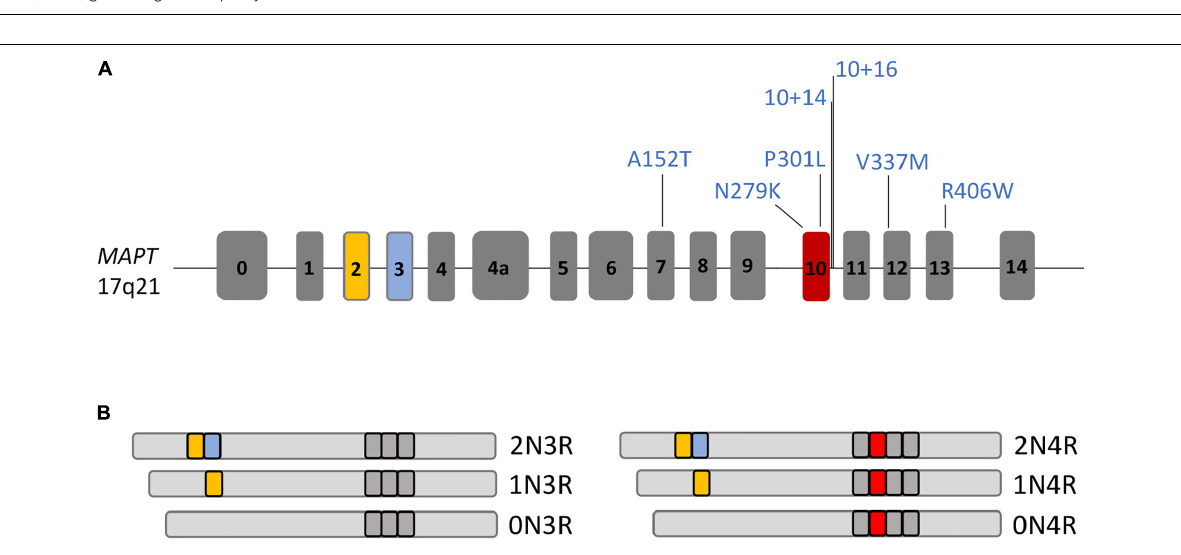
FIGURE 2 | Classification of frontotemporal dementia / frontotemporal lobar degeneration. (A) FTLD is subdivided into FTLD-tau with deposition of hyperphosphorylated tau, FTLD-TDP with TDP-43 pathology, FTLD-FET with deposition of FET proteins as well as FTLD-UPS with deposition of ubiquitinated proteins. The percentage, clinical presentation, deposited proteins and associated mutations are listed for each FTLD subtype. (B) FTLD-tau (highlighted in blue) is further subdivided into 3R and 4R tauopathies as well as a small group of patients with unaltered 3R:4R ratio. Human iPSC models have been established for some FTLD-tau subtypes (in red). bvFTD, behavioral variant of frontotemporal dementia; PSP, progressive supranuclear palsy; CBS, corticobasal syndrome; svPPA, semantic variant of primary progressive aphasia; nfPPA, non-fluent variant of PPA; FTD-MND, FTD with motor neuron disease; TDP-43, transactive response DNA binding protein molecular weight 43; FUS, fused in sarcoma; EWS, Ewing‘s sarcoma; TAF15, TATA-binding protein-associated factor 15; GRN, granulin; C9orf72, chromosome 9 open reading frame 72; VCP, valosin-containing protein; TARDBP, TAR DNA-binding protein 43; CHMP2B, charged multivesicular body protein 2B; Pick’s, Pick’s disease; FTDP-17, Frontotemporal Dementia and Parkinsonism linked to chromosome 17; CBD, corticobasal degeneration; AGD, argyrophilic grain disease; GGT, globular glial tauopathy.